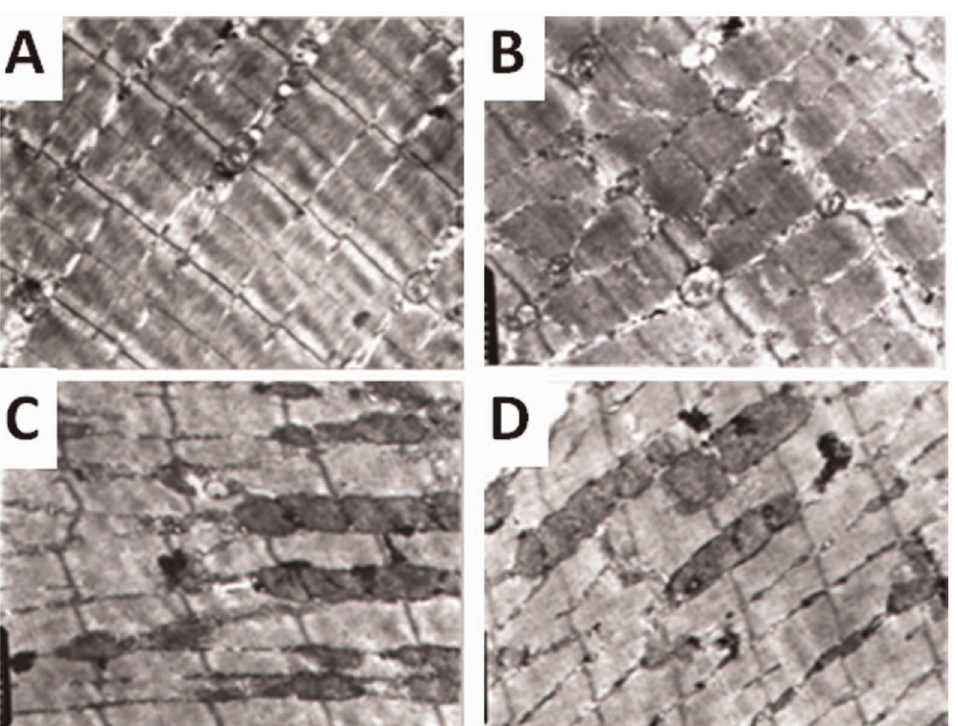
Fig. 6. The structure of mitochondria in skeletal muscle of VMC mice (magnification 10,000 6 ). ( a ) Skeletal muscle of normal mouse. The mitochondria were circle or elliptical with legible and densely packed cristae. There were also abundant glycogen granule, legible sarcoplasmic reticulum and T tube near Z line. ( b ) Skeletal muscle in mice 3 days after virus infection. The mitochondria swelled, the number of mitochondrial cristae decreased or disappeared, sarcoplasmic reticulum dilated, and glycogen granule decreased. ( c ) Skeletal muscle in mice 11 days after virus infection. The mitochondria proliferated and swelled; glycogen granule decreased. ( d ) Skeletal muscle in mice 24 days after virus infection. The mitochondria proliferated and swelled; sarcoplasmic reticulum